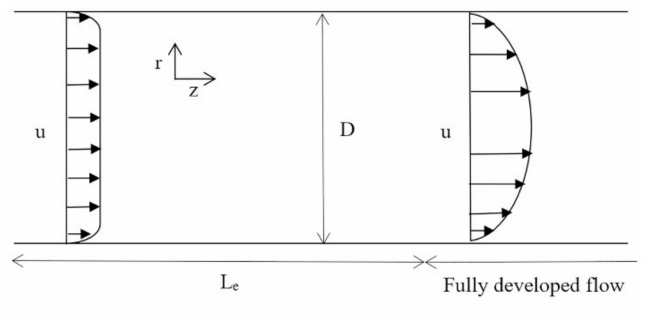
Figure 5. Internal flow in